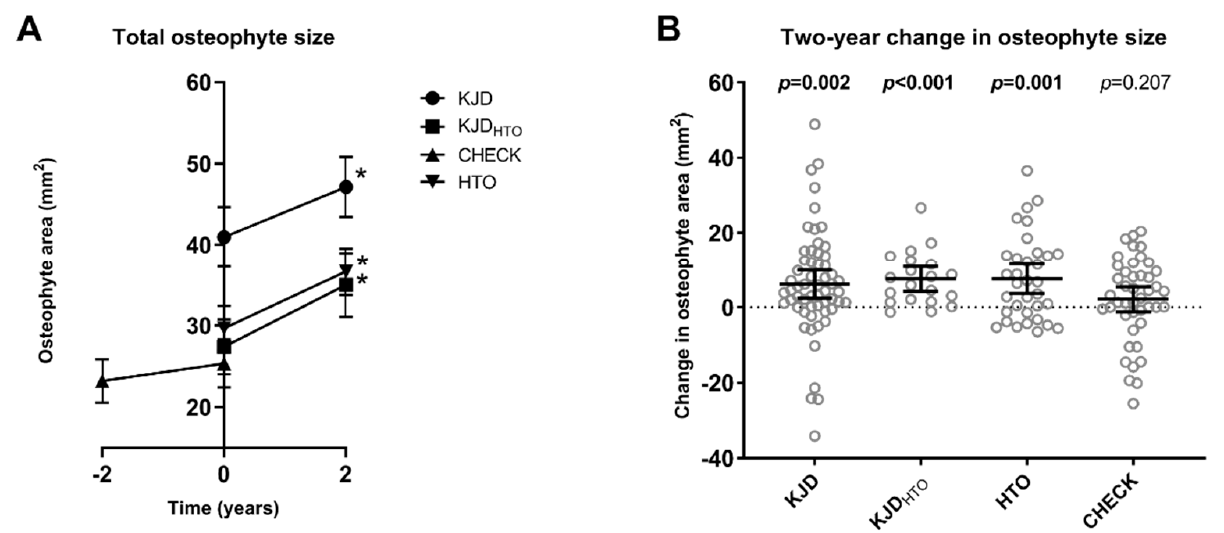
Figure 3. Two year changes in total joint osteophyte size in mm 2 . ( A ) Osteophyte size after treatment for all patients treated with knee joint distraction (KJD, n = 58), high tibial osteotomy (HTO, n = 36), HTO-indicated KJD patients (KJD HTO , n = 20), and for untreated knee osteoarthritis patients before receiving a total knee arthroplasty (CHECK, n = 44). Mean and standard error of the mean (SEM) are shown, * indicates significant changes ( p < 0.05) compared to baseline using paired t -tests. ( B ) Two-year osteophyte size changes for individual KJD, HTO, KJD HTO and CHECK patients. Mean and 95% confidence interval are shown, p -values above groups indicate significance of two-year changes using paired t -tests (bold values indicating statistical